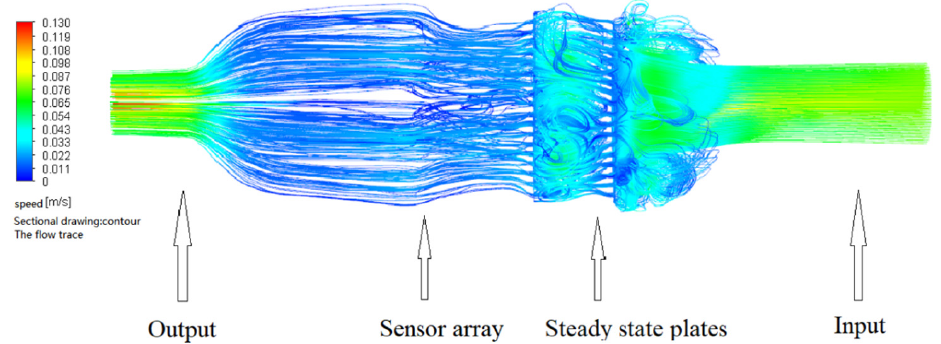
Figure 15. The flow field simulation cavity structure with steady flow plates.